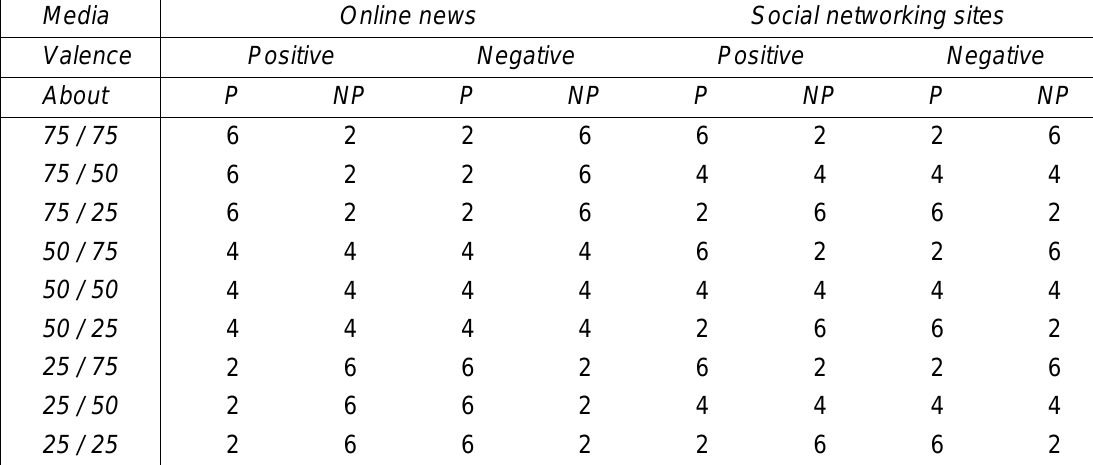
Table 1: Distribution of item content in the nine experimental conditions.